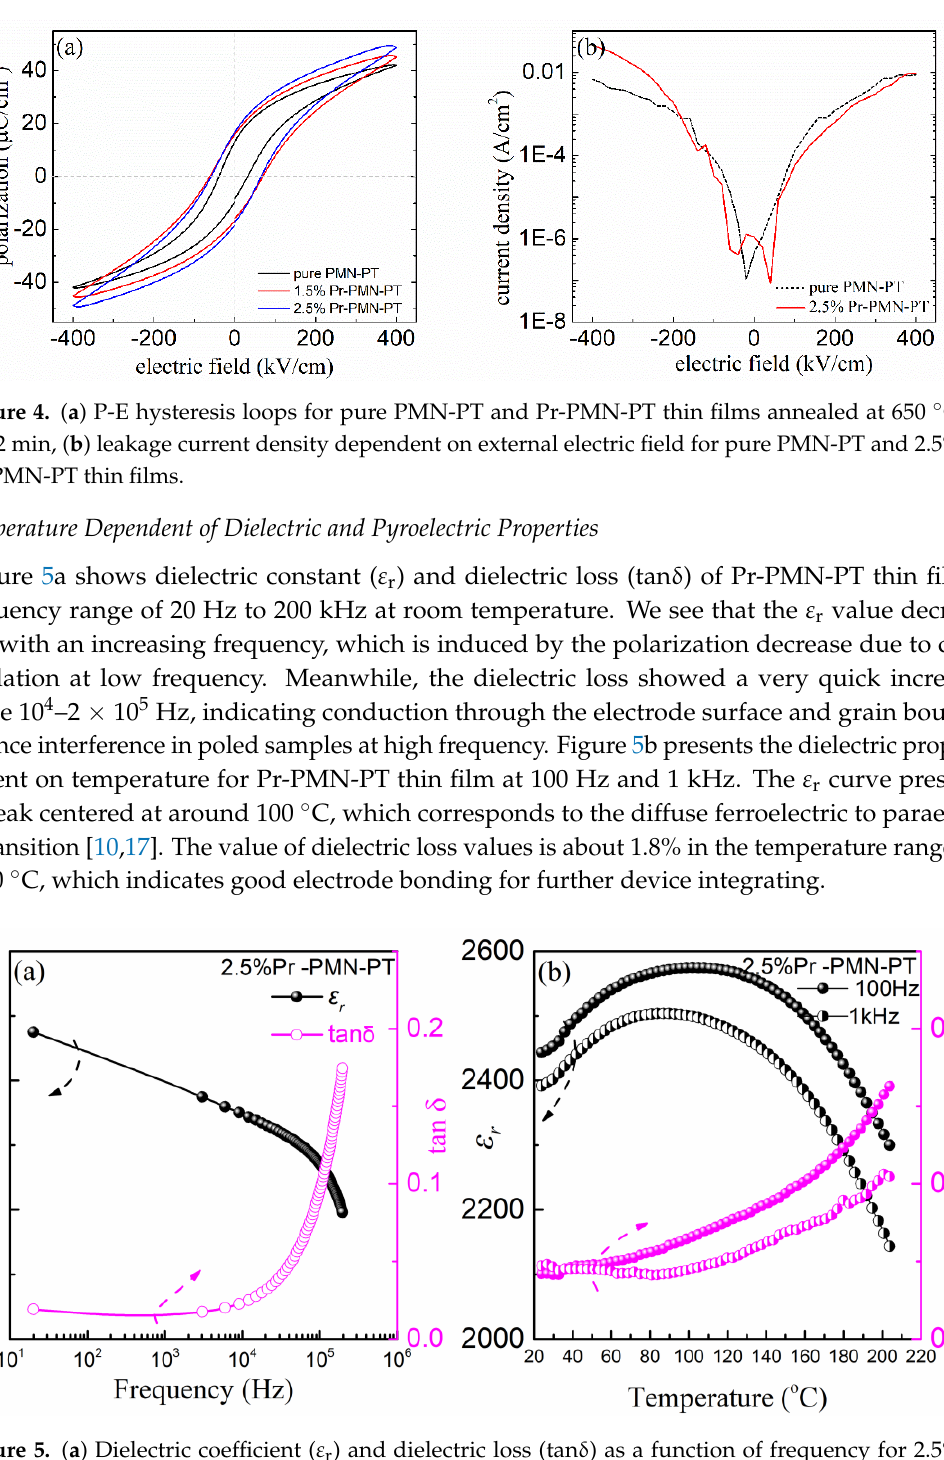
Figure 5. ( a ) Dielectric coefficient ( ε r ) and dielectric loss (tanδ) as a function of frequency for 2.5% Pr-PMN-PT thin films annealed at 650 °C for 2 min, ( b ) dielectric coefficient and dielectric loss as a function of temperature for 2.5% Pr-PMN-PT thin films at 100 Hz and 1 kHz.